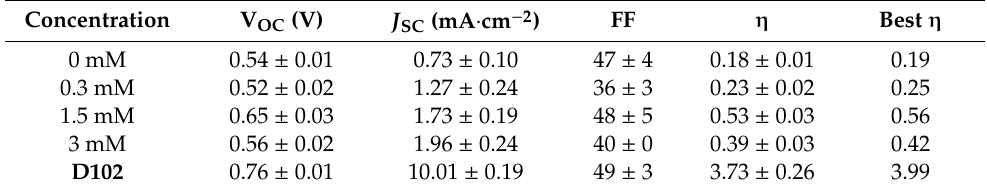
Table 2. Photovoltaic parameters of ssDSSCs sensitized with M2 or D102 under simulated solar emission (100 mW · cm − 2 , AM1.5G) as a function of the co-adsorbent concentration: short-circuit current